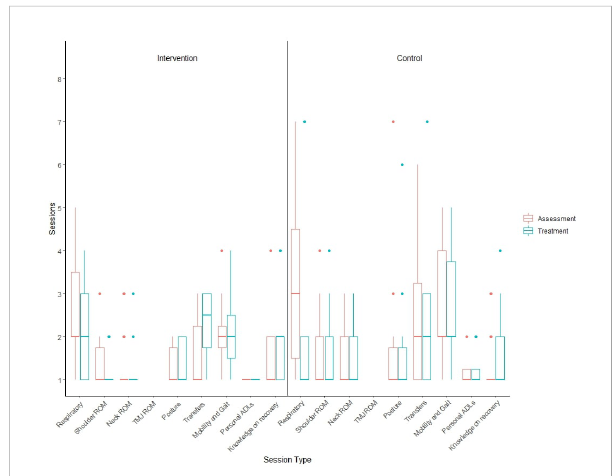
FIGURE 2 Boxplot illustrating the number of GRRAND sessions attended by participants for each of the in-patient programme.